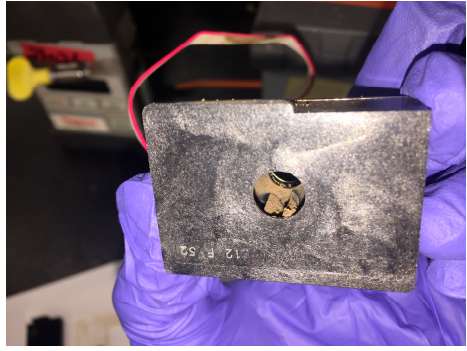
Figure 9. Dust fouled the active Sharp sensor after just 19 weeks of deployment in the factory.